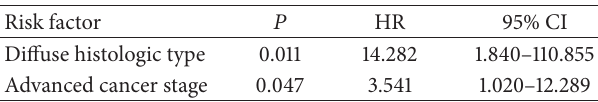
Table 6: Independent risk factor influencing survival after multivariate analysis by Cox proportional hazard models.